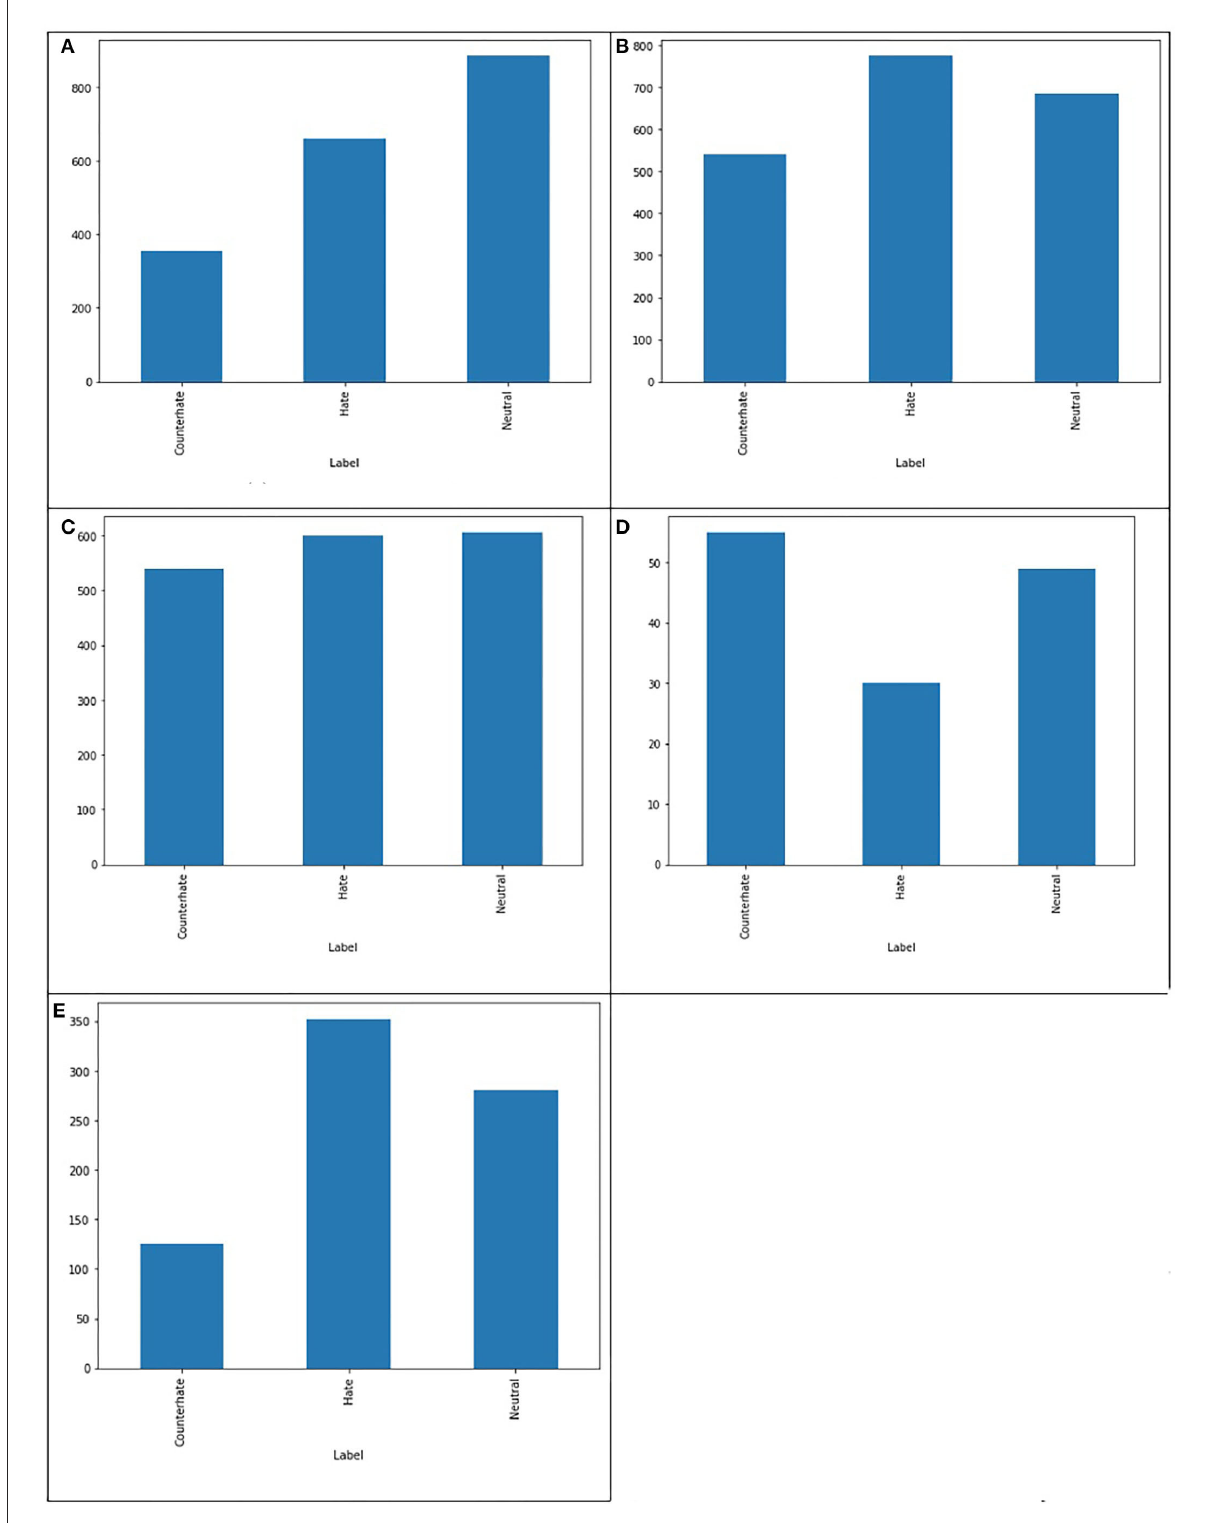
FIGURE2 Comparing the balance in the number of tweets in each class in different datasets. (A) Baseline dataset, (B) Our dataset, (C) Our improved dataset, (D) Ambiguous dataset, and (E) Dataset with full